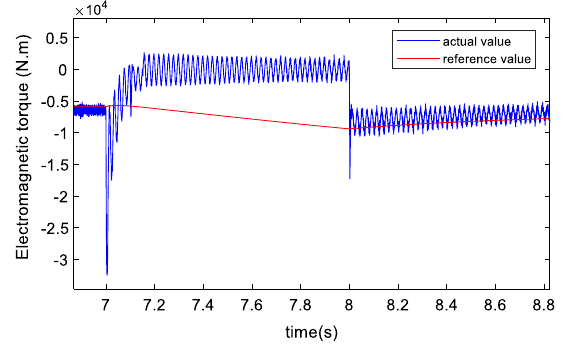
Fig. 24 Electromagnetic torque of the DFIG during symmetrical voltage sag